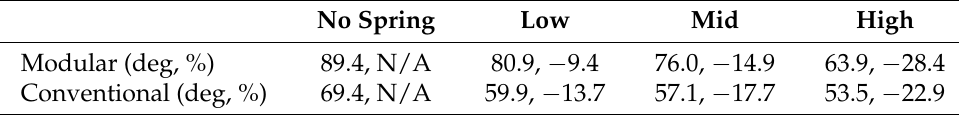
Figure 14. Maximal joint ROMs at 200 kPa for different joint stiffness values. Table 4. Maximal ROM value and rate of change for different joint